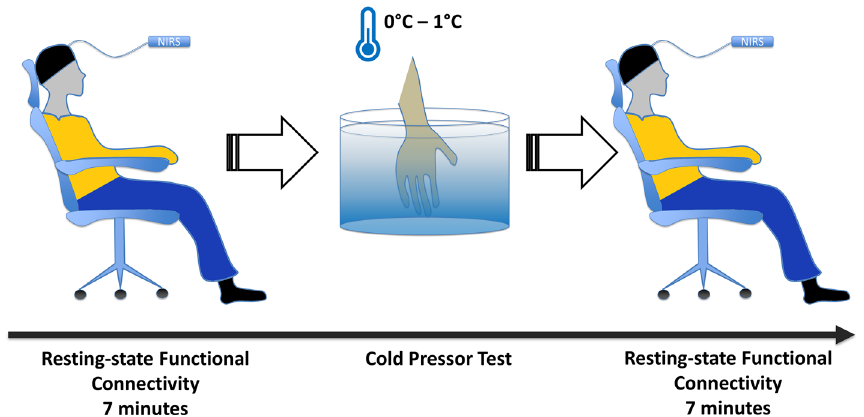
Figure 2. fNIRS connectivity assessment. The cold pressure test lasted from a minimum of 10 s until maximum tolerance to pain. Pre and post-stimuli functional connectivity yielded a difference in Z values